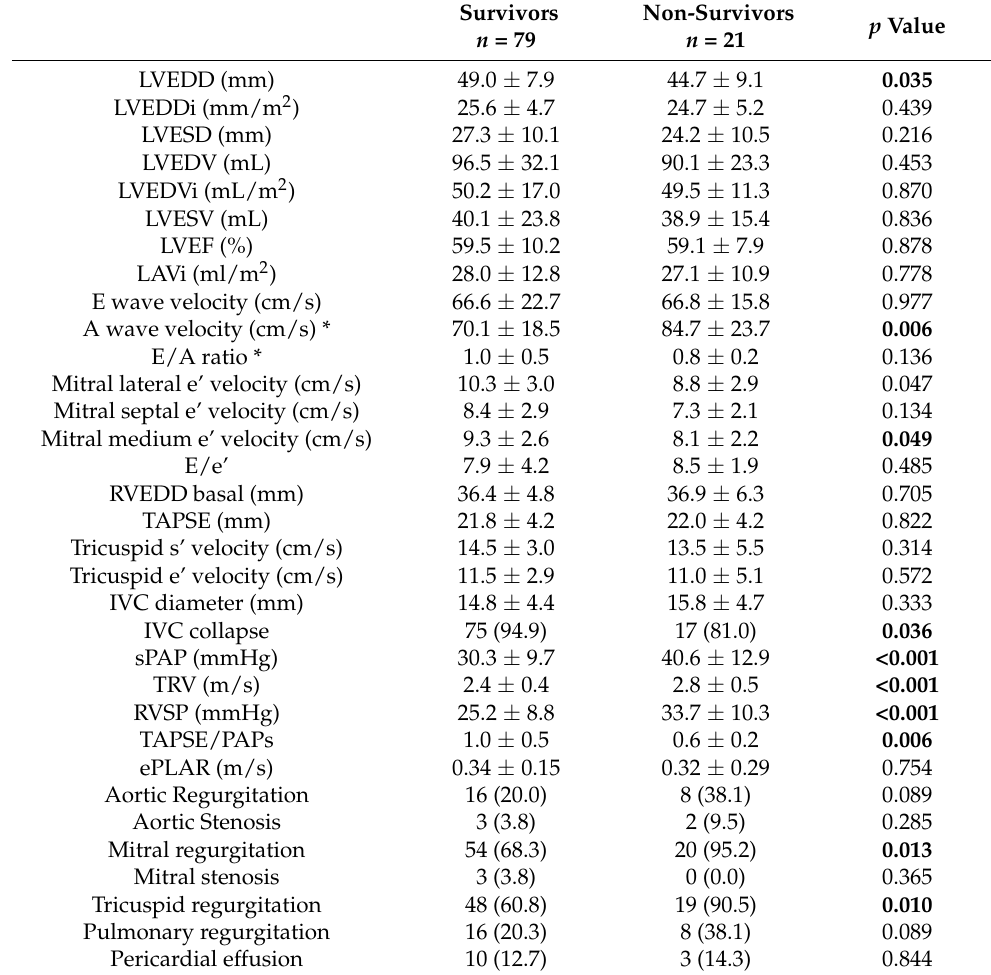
Table 4. Echocardiographic parameters of survivor and non-survivor patients with